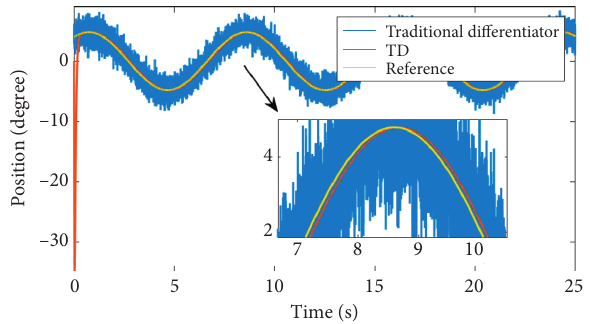
Figure 6: Differentiator with random